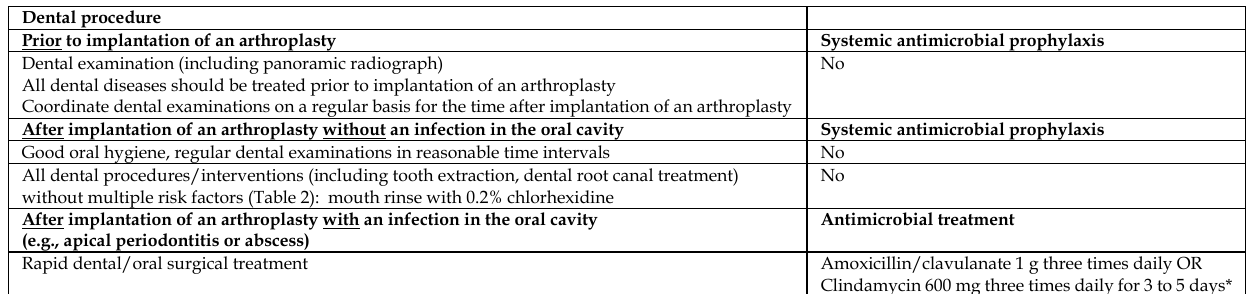
No No Antimicrobial treatment